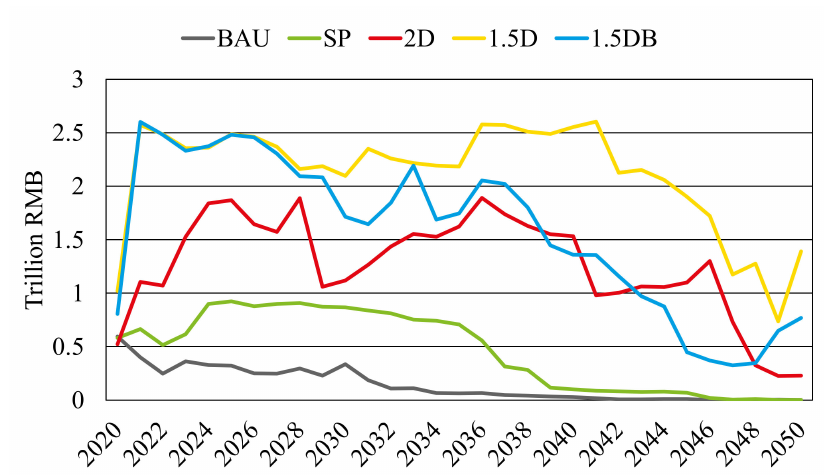
Figure 3. Annual investment demand on infrastructure from 2020 to 2050.